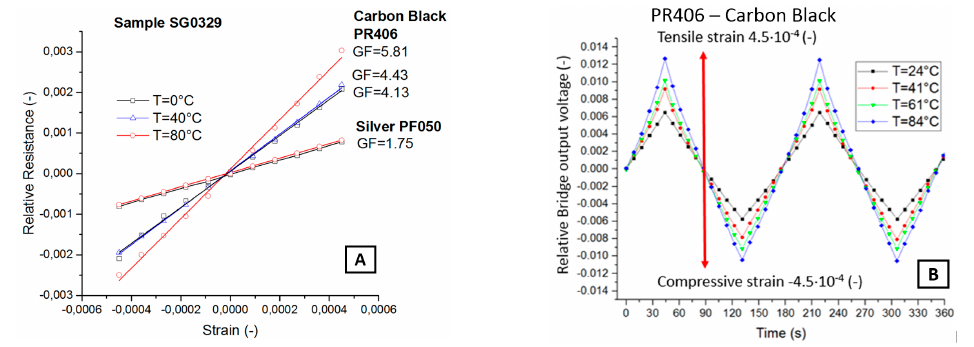
Figure 4. Relative resistance and GF comparison for silver and carbon black samples at different operating temperatures ( A ) and relative bridge voltage of carbon black sample under strain changes ( B ) measured at different operating temperatures.